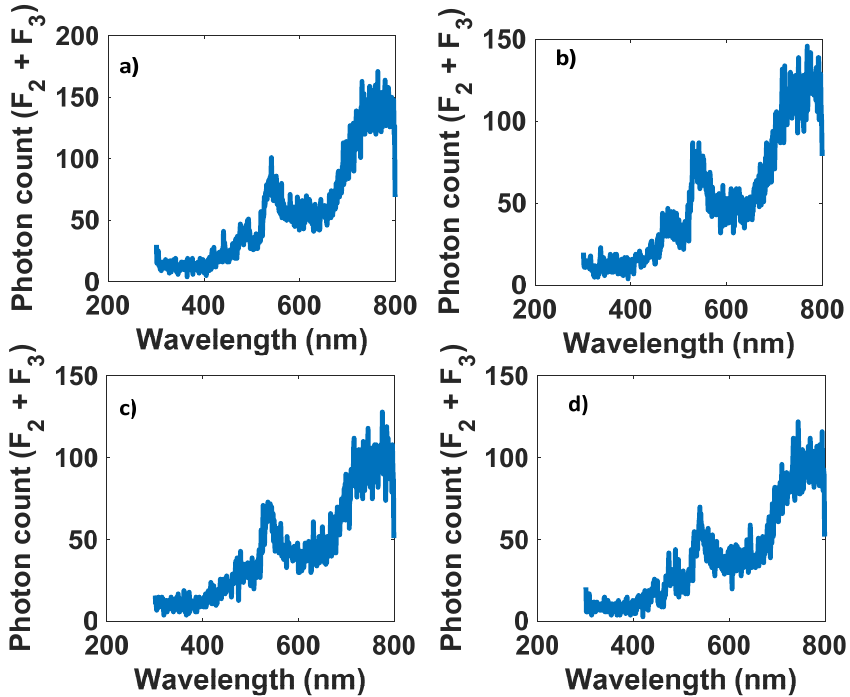
Figure 17. Structures with optical efficiencies over 20 (%). ( a ) L = 10 cm, R = 5 cm, QY = 0.95, Concentration = 3.88 × 10 8 (1/cm 3 ), η opt = 29.0990 (%). ( b ) L = 8 cm, R = 5 cm, QY = 0.95, Concentration = 3.88 × 10 8 (1/cm 3 ), η opt = 25.7964 (%).( c ) L = 6 cm, R = 5 cm, QY = 0.95, Concentration =3.88 × 10 8 (1/cm 3 ), η opt = 22.0142 (%). ( d ) L = 10 cm, R = 3 cm, QY = 0.95, Concentration = 3.88 × 10 8 (1/cm 3 ), η opt = 20.1008 (%).